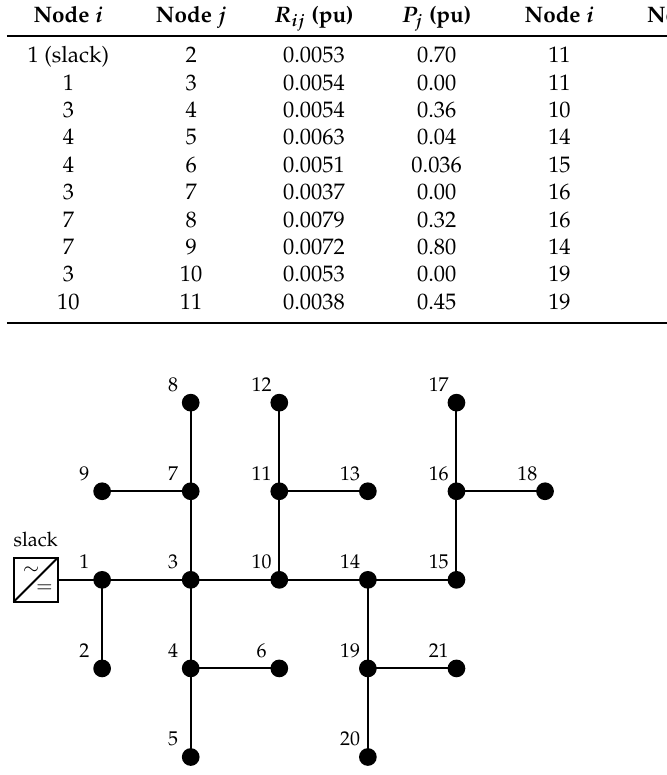
Figure 1. Grid configuration of the 21-bus system. Table 2. Demand and energy cost variations for a typical day of